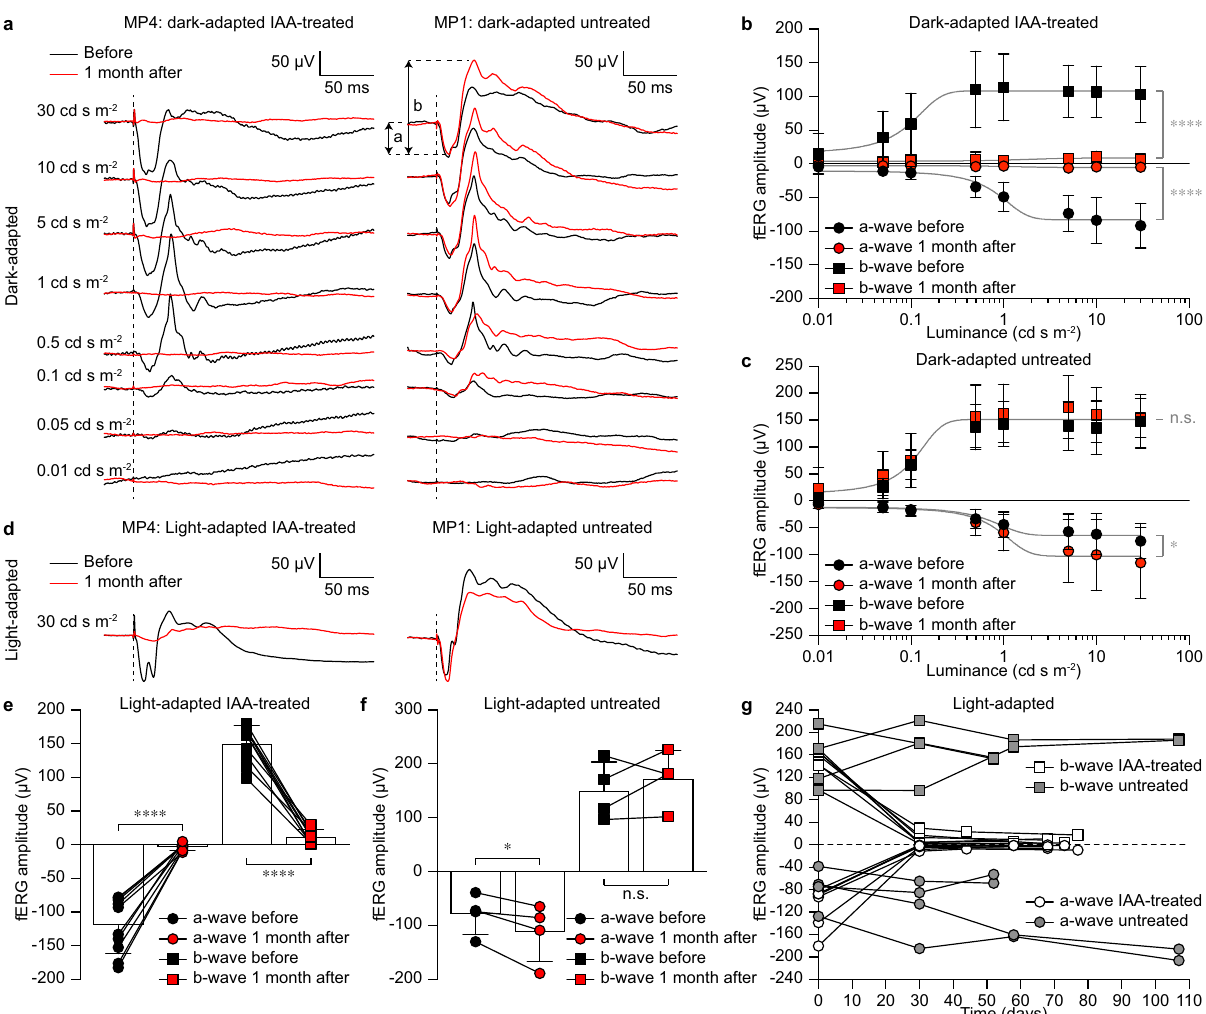
Fig. 2 fERGs in blind minipigs. a Dark-adapted responses in an IAA-treated minipig before and 1 month after IAA administration and in an untreated minipig at matching time points. The dashed lines indicate the fl ash onset. The quanti fi cation of the a-wave and b-wave is indicated. b , c Quanti fi cation of the dark-adapted fERGs in IAA-treated (mean ± s.d., n = 10 eyes from N = 5 minipigs) and untreated (mean ± s.d., n = 4 eyes from N = 2 minipigs) animals. Grey lines are the logistic growth regressions for IAA-treated (a-wave before: R2 = 0.6973; a-wave after: R2 = 0.0975; b-wave before: R2 = 0.3972; b-wave after: R2 = 0.0723) and untreated (a-wave before: R2 = 0.5283; a-wave after: R2 = 0.5368; b-wave before: R2 = 0.7283; b-wave after: R2 = 0.6258) minipigs. Extra sum-of-squares F test; IAA-treated: p < 0.0001 (****) for both a-wave and b-wave; untreated: p = 0.0355 (*) for a-wave and p = 0.3235 (n.s.) for b-wave. d Light-adapted responses in an IAA-treated minipig before and 1 month after IAA administration and in an untreated minipig at matching time points. The dashed lines indicate the onset of the fl ash. e , f Quanti fi cation of the light-adapted fERGs in IAA-treated (mean ± s.d., n = 10 eyes from N = 5 minipigs) and untreated (mean ± s.d., n = 4 eyes from N = 2 minipigs) animals. Two-tailed paired t -test; IAA-treated: p < 0.0001 (****) and power 1.00 for both a-wave and b-wave; untreated: p = 0.0463 (*) and power 0.97 for a-wave and p = 0.4043 (n.s.) and power 0.71 for b-wave. g Quanti fi cation of the light-adapted fERGs in IAA-treated ( n = 7 eyes from N = 5 minipigs) and untreated ( n = 4 eyes from N = 2 minipigs) minipigs over time. IAA was administered on day 0 after the recordings. Data in panels a , d are from MP4 (IAA-treated) and MP1 (untreated). Data in panels b , c , e – g are from MP4 – 8 (IAA-treated) and MP1 – 2 (untreated). Source data are provided as a Source Data fi